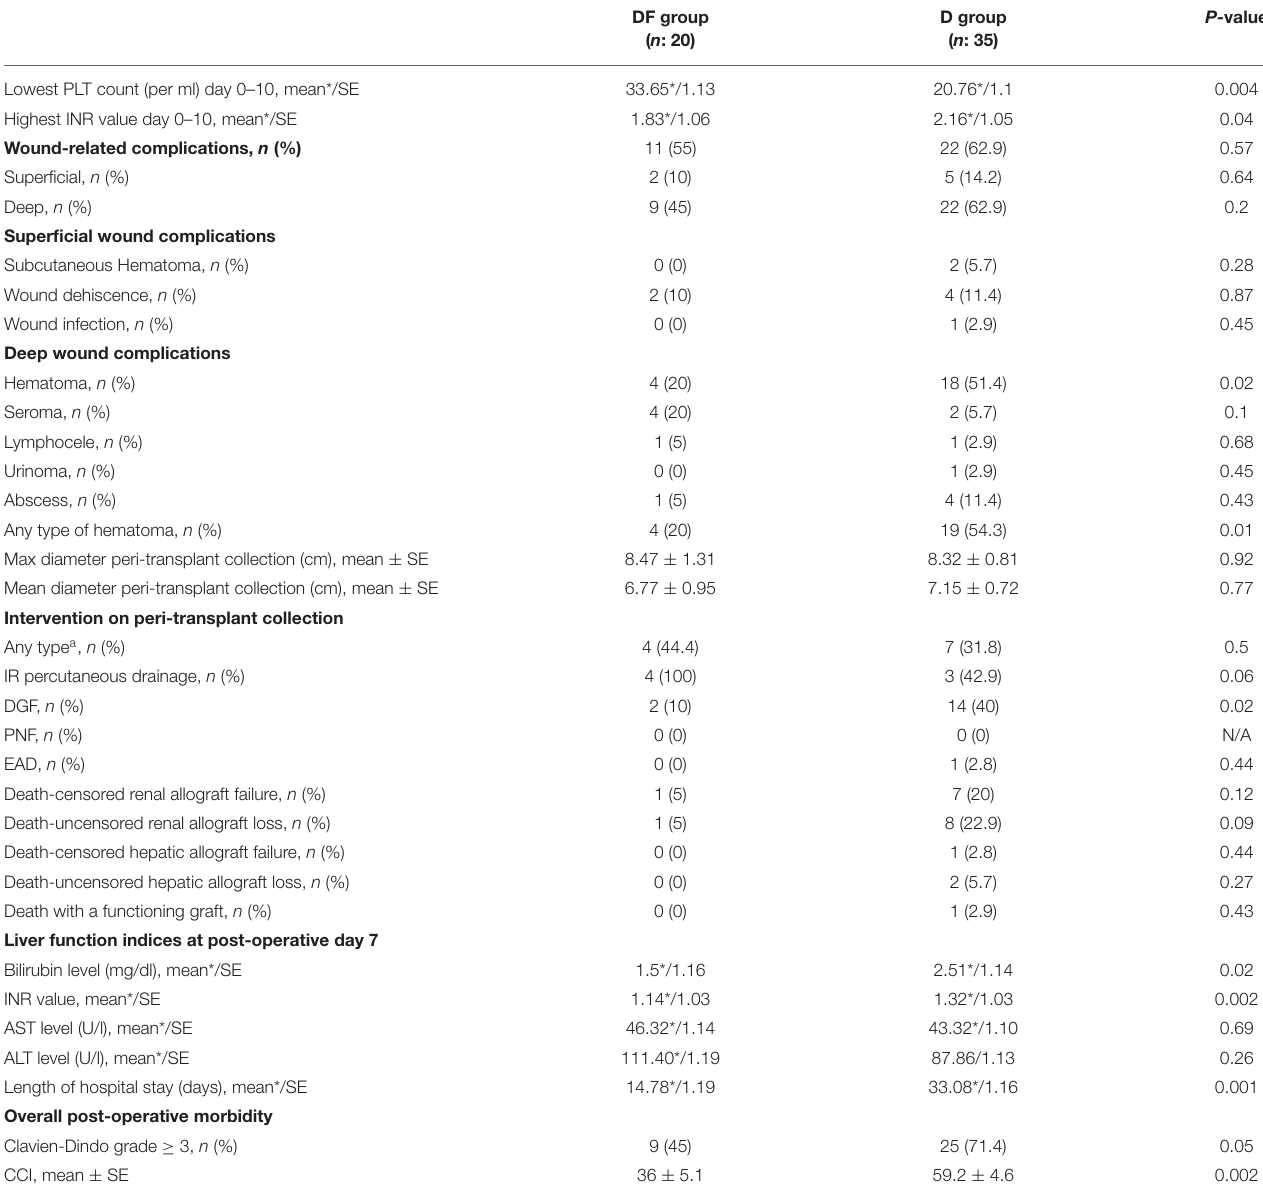
TABLE 4 | Post-operative outcomes analyzed.